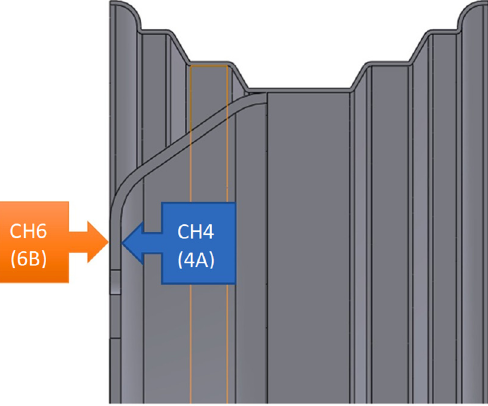
Figure 4. Location of strain gauge for channels CH4 (inner rim) and CH6 (outer rim). Reproduced from [12] with permission from Elsevier.